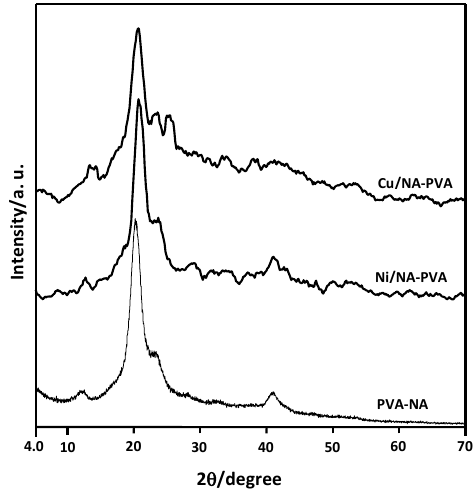
Figure 6. XRD patterns of Ni/PVA-NA and Cu/PVA-NA samples.